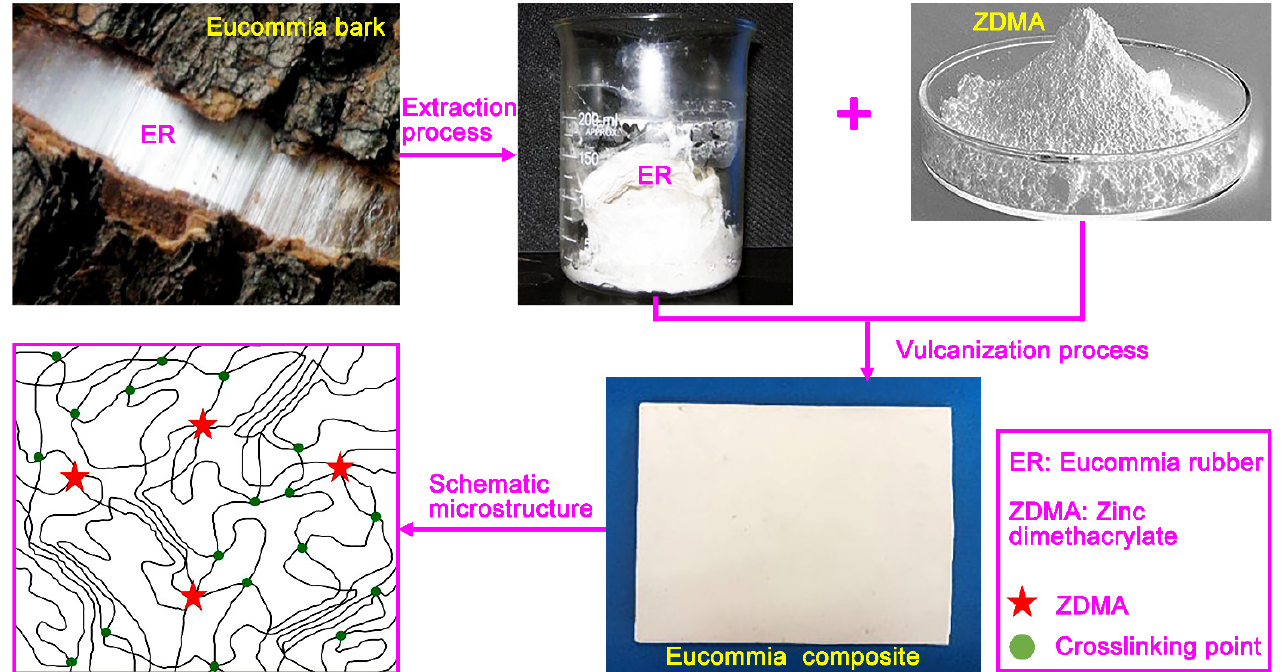
Figure 1. Schematic illustration of preparation for ER composite. Table 1. Formulation of the ER composites.